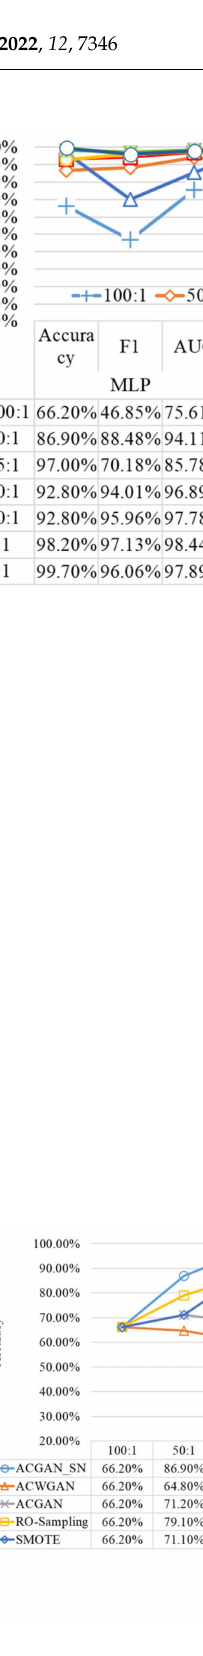
Figure 11. Diagnosis results with different data augmentation approaches: ( a ) MLP-based model and ( b ) BiLSTM-based